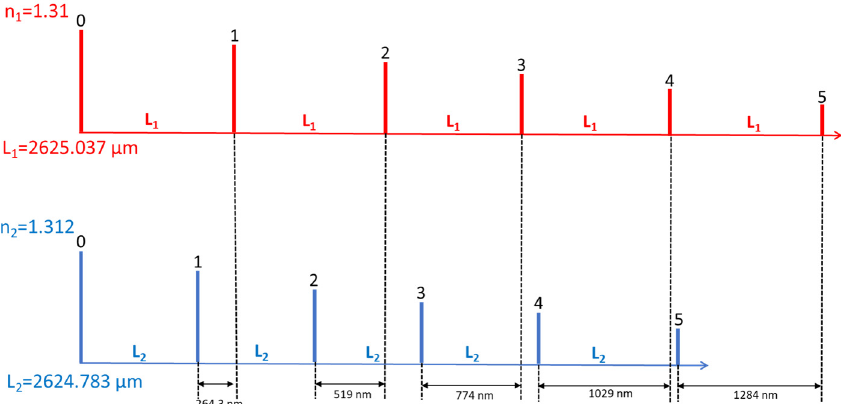
Figure 5. The different interferogram orders in the spatial domain for the MRR with a 100 µ m radius.